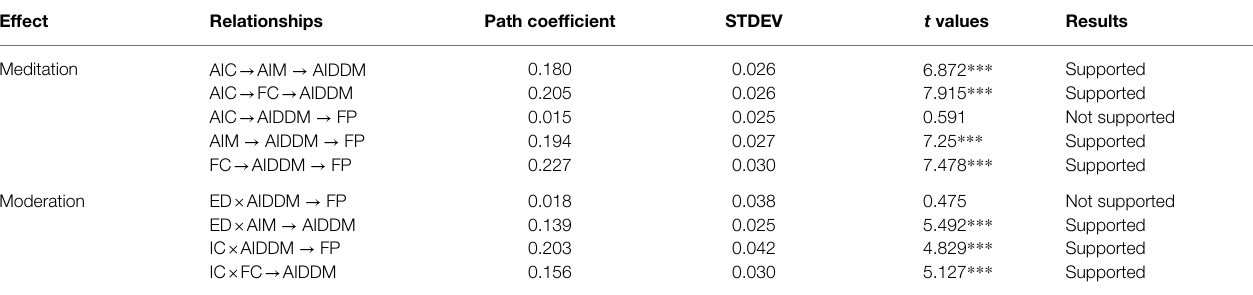
TABLE 8 | Results of meditation and moderation. Effect Relationships Path coefficient Meditation